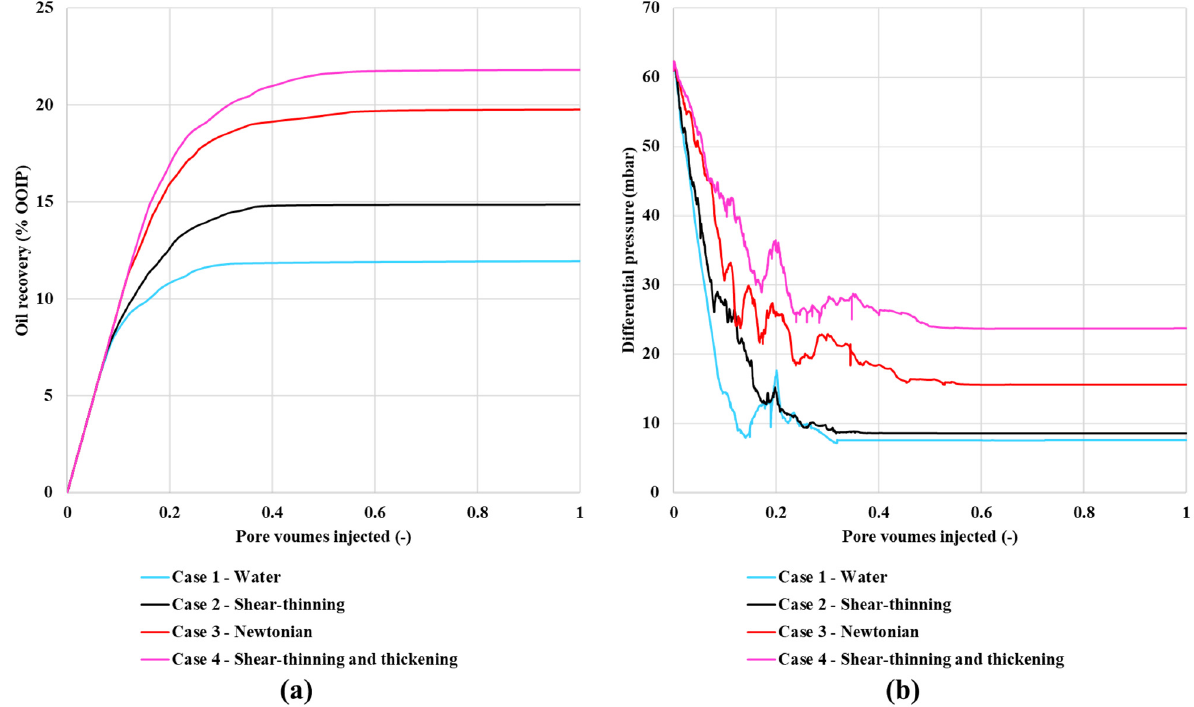
Figure 21. ( a ) Oil recovery and ( b ) differential pressure versus pore volumes injected for the longer (200 × 25) pore network model.